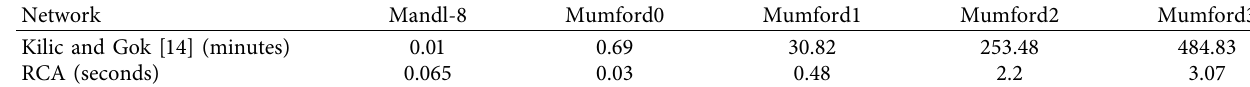
Table 5: Comparison of computation time of initialization procedures.